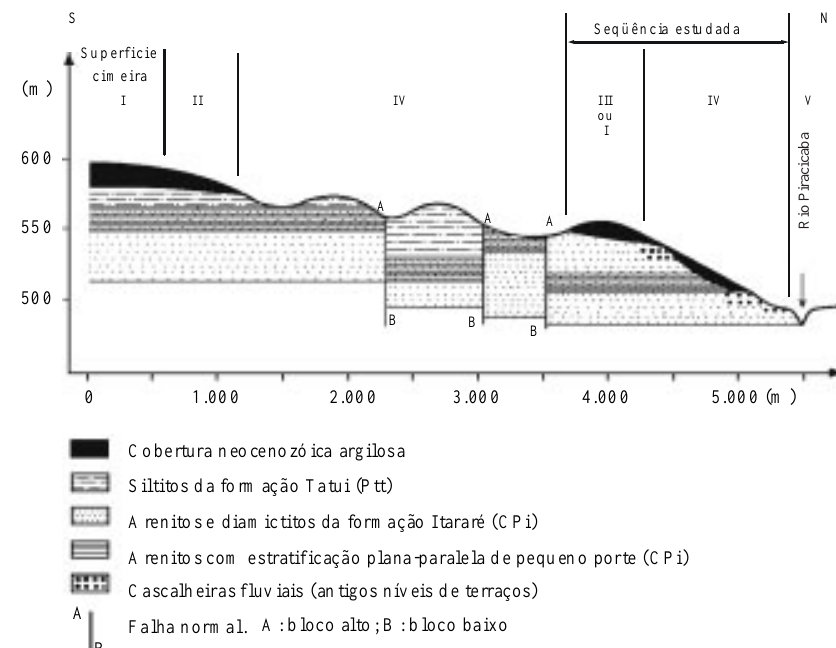
Figura 2. Seção transversal da área de estudo, localizando os solos estudados, a litologia e as superfícies geomórficas (Vidal Torrado, 1994). I, II, III, IV e V, sendo I a mais antiga e V a mais